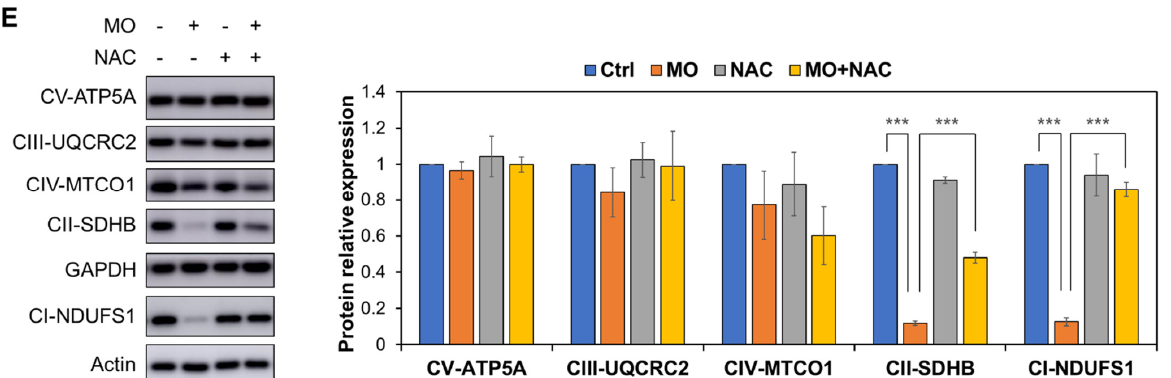
Figure 6. MO-induced apoptosis and mitochondrial dysfunction were mediated by ROS production. HCT116 cells were treated with Ctrl or MO (375 µ g/mL) with or without 5 mM NAC for 48 h. After treatment, cell viability was determined by trypan blue exclusion staining ( A ), ROS level was measured by carboxy-H 2 DCFDA staining ( B ), apoptosis analysis was performed based on Annexin V/PI counter stain ( C ), and the MMP was determined by JC-1 red-to-green ratio ( D ). Data from ( B ) to ( D ) were acquired by flow cytometry. All data are presented by the averaged percentage of cell population ± SD from three replicates. ( E ) Protein expression levels of OXPHOS complexes were analyzed by western blot and normalized to GAPDH or Actin expression. Bars represent the relative protein expression of complex I to V (CI to CV). Relative values (mean ± SD, n = 3) were normalized to GAPDH or Actin expression and vehicle-treated controls. *** p < 0.001, ** p <